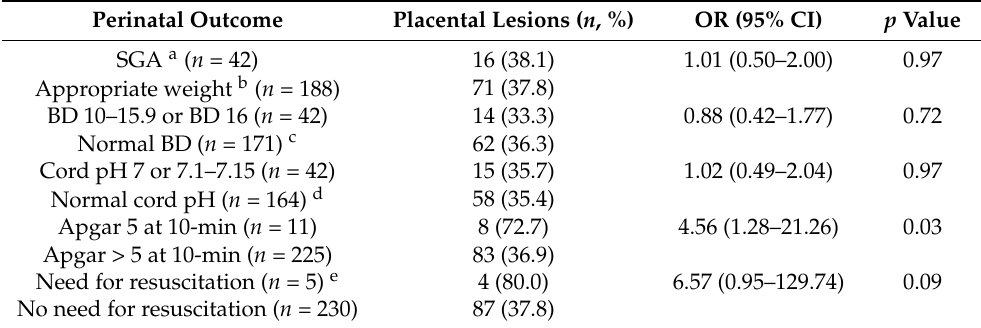
Figure 1. Directed Acyclic Graph (DAG) showing the assumed confounding effects of maternal smoking, preeclampsia, chronic hypertension, and gestational or chronic diabetes with the mediators of prematurity and birthweight between placental lesions and NICU admission. E—exposure; O—outcome; C—confounder; M—mediator. Table 3. The effect of placental abruption and underlying lesions on perinatal